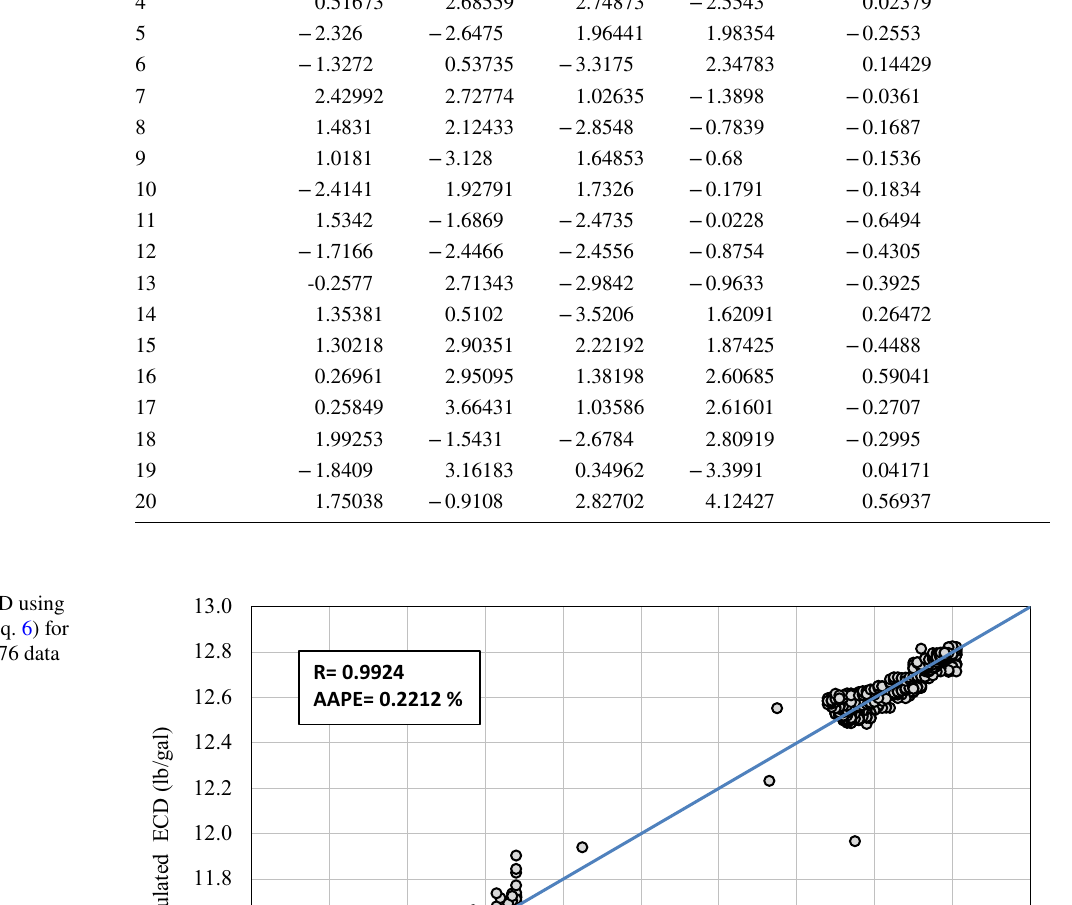
Table 3 The weights and biases of the ECD empirical correlation (Eq. 2)